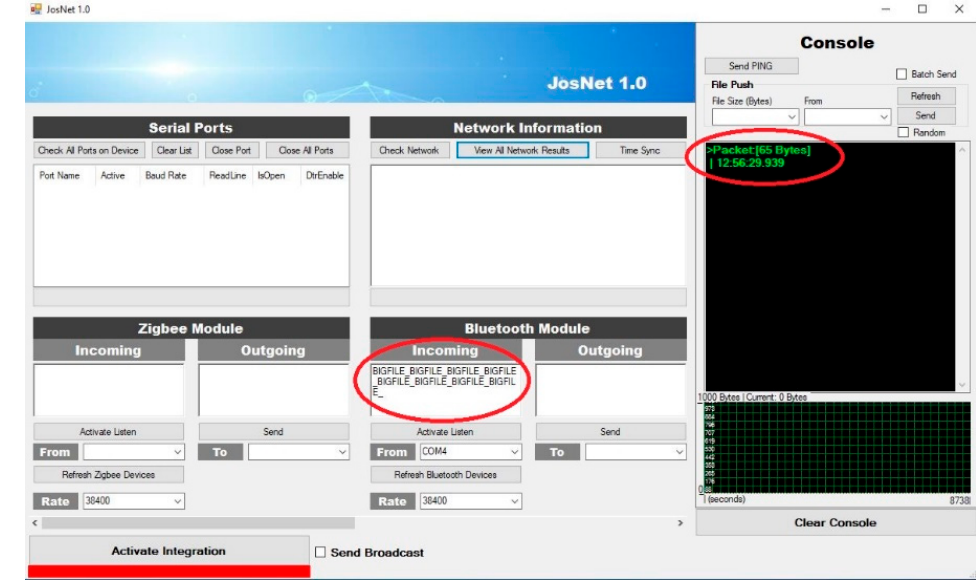
Figure 16. Bluetooth node (BL2) receiving 64 bytes of data from Station 2. Experimental Setup 7: Zigbee Mesh Broadcast Message—20 ‐ m Wall Barrier